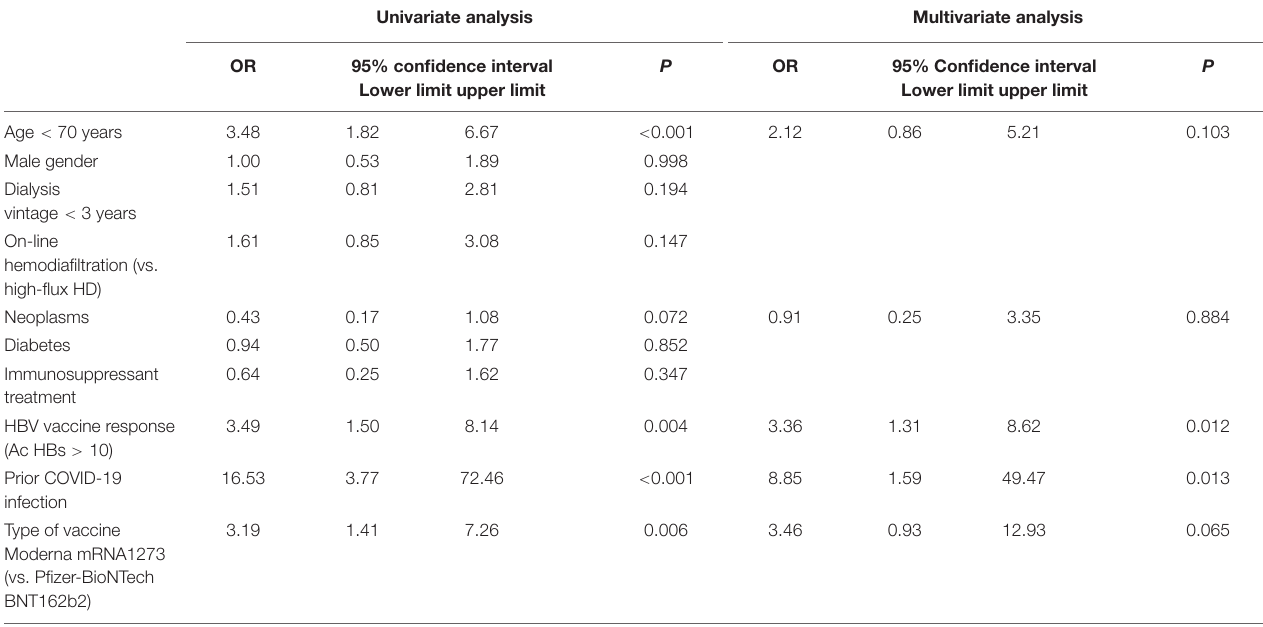
TABLE 3 | Univariate and multivariate logistic regression for predicting sustained effective humoral response (SARS-CoV-2 anti-S-RBD antibody levels > 1,000 AU/ml) 4 months after the initial two mRNA doses. Univariate analysis Multivariate analysis